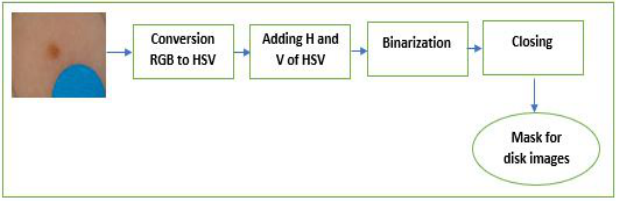
Figure 9. Disk removal mask